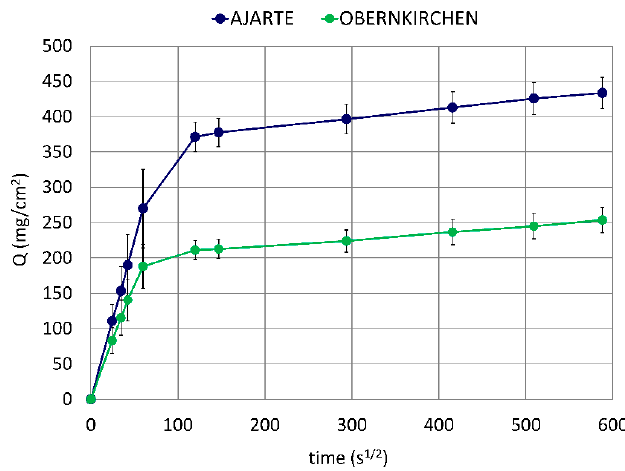
Figure 2. Water absorption by capillarity in untreated lithotypes.